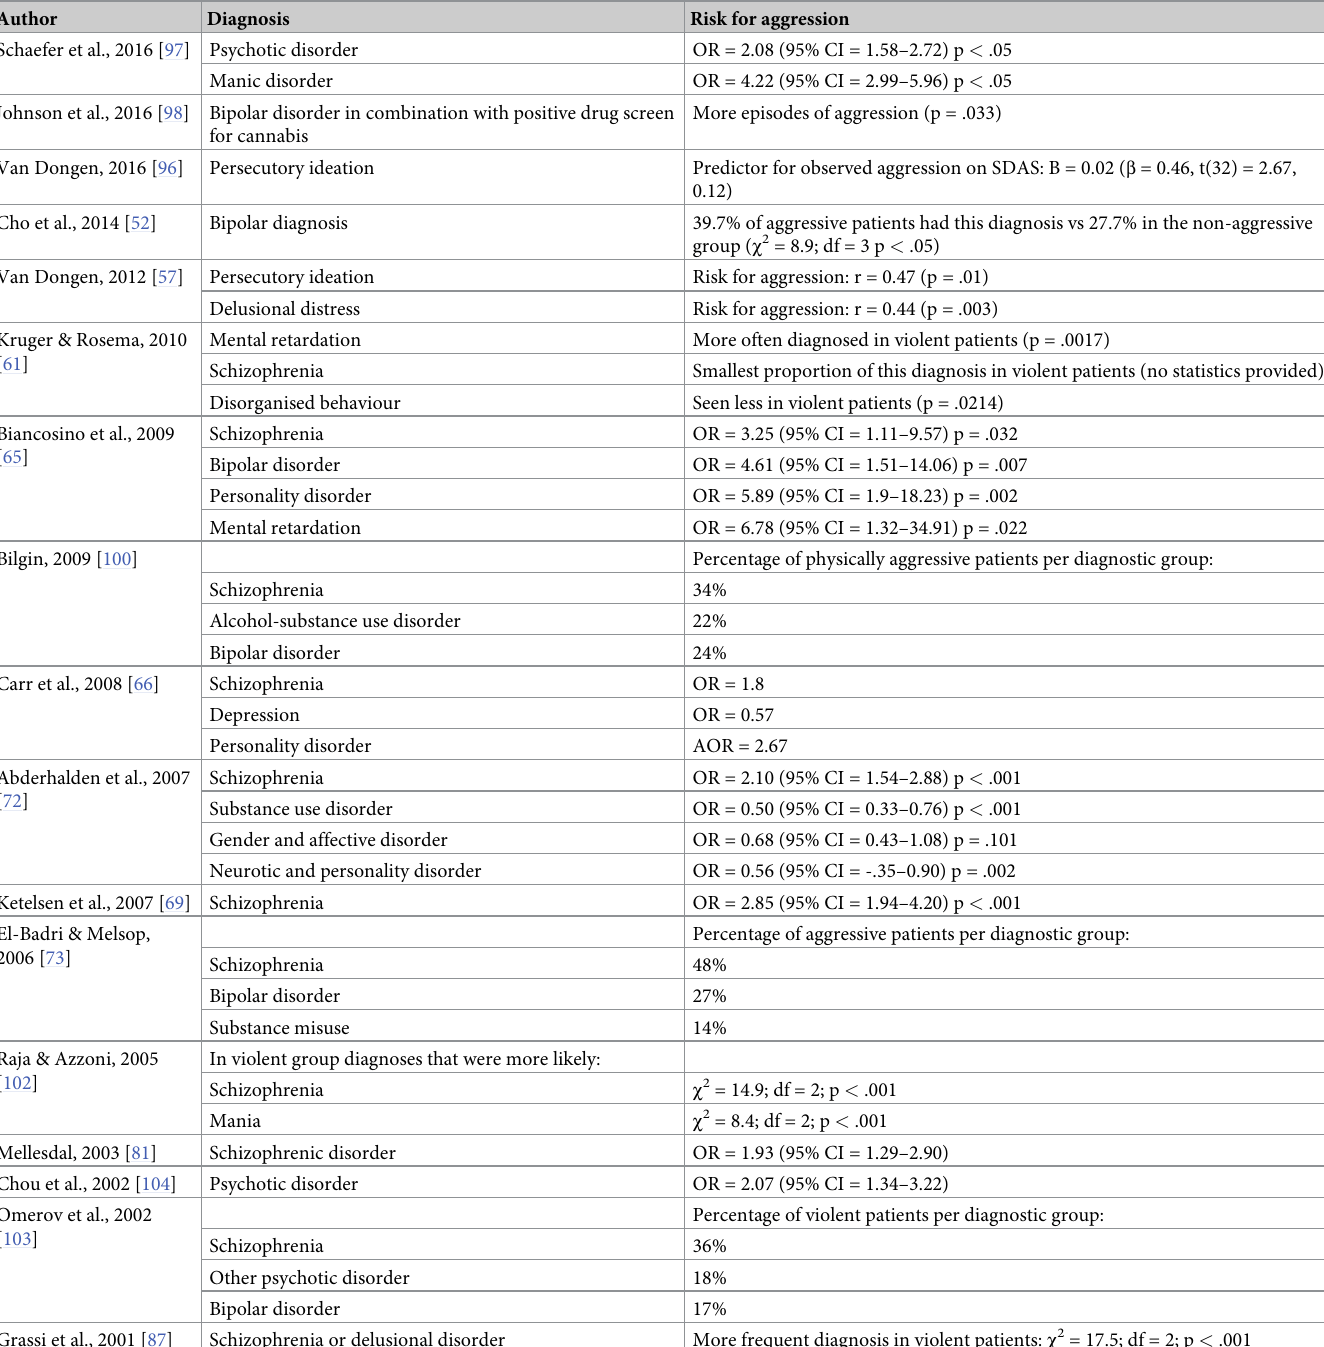
Table 1. Included studies on the possible association of patient diagnosis and the development of